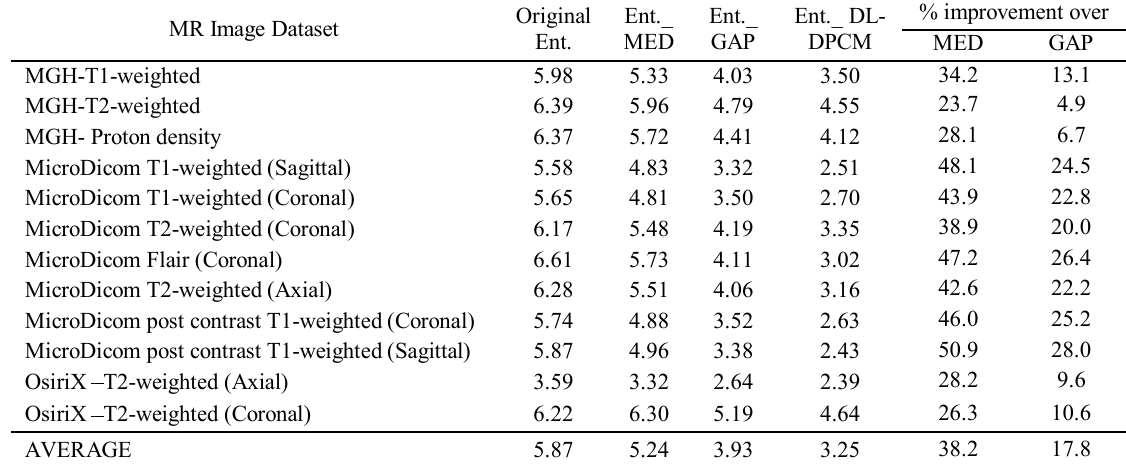
Table 4. First order entropy values for original image and prediction error images (i.e. difference of original and predicted image) obtained by the predictors MED, GAP and DL-DPCM MR Image Dataset